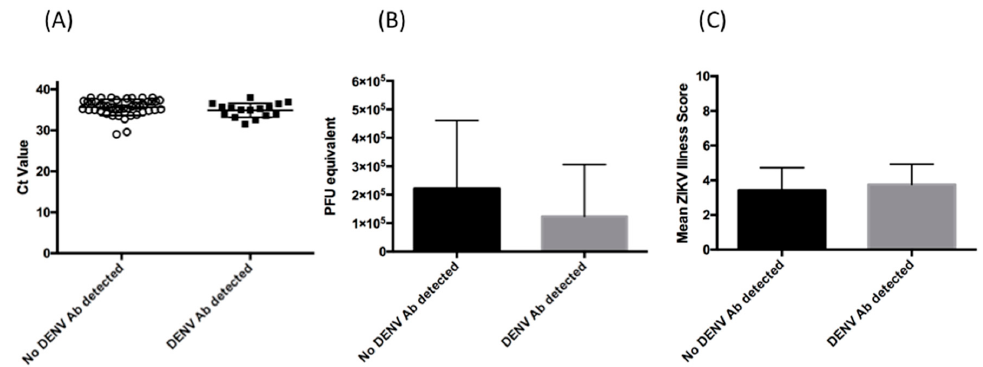
Figure 1. Relative magnitude of viremia and disease severity. ( A ) ZIKV RNA Ct values as a measure of viremia in patients who were DENV PRNT negative (black circles) and those with evidence of DENV or flavivirus exposure, based on DENV PRNT (black squares). The lines represent the mean and error bars represent standard deviation. ( B ) PFU equivalents as in interpolated from Ct values. The bars represent the means, and error bars represent standard deviation. ( C )Mean Zika illness score for patients. The total number of symptoms for patients with (grey bars) or without (black bars) previous serological evidence of DENV exposure was determined and used to generate a disease severity